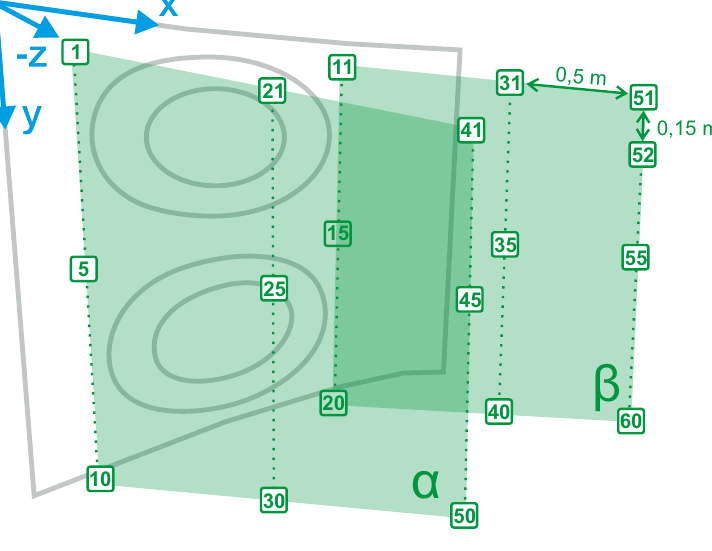
0.5 m, z = 1 m or z = 1.5 m in front of the − − −